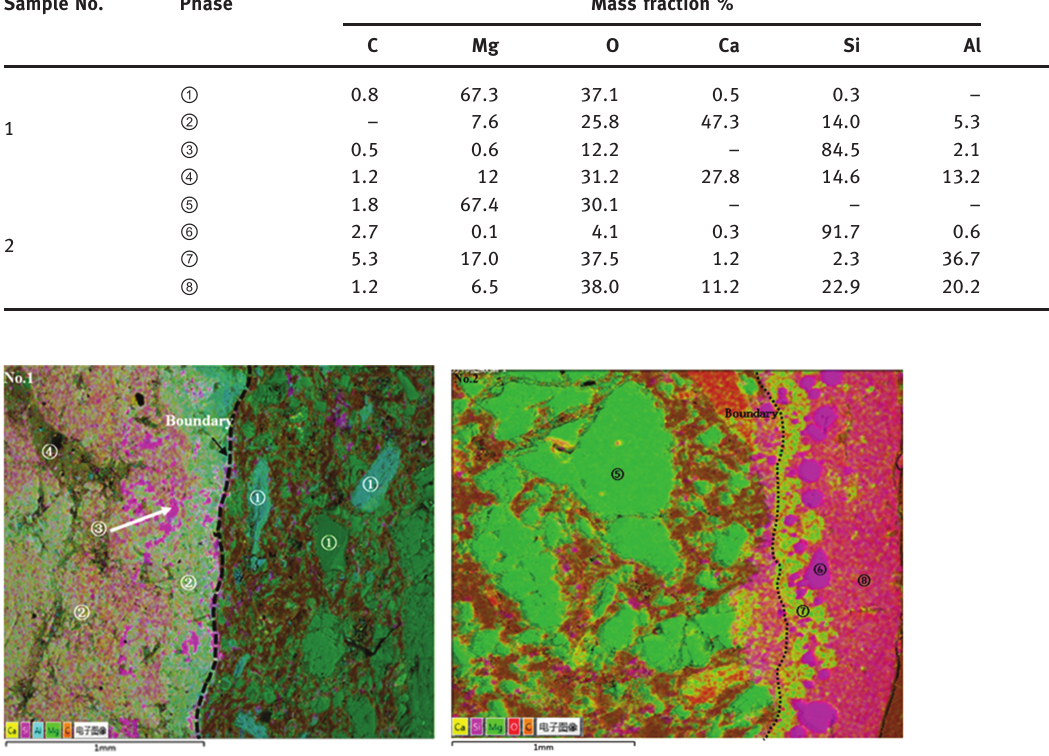
.Table 2: Cathodic sediment phase composition of different slag. Sample No.